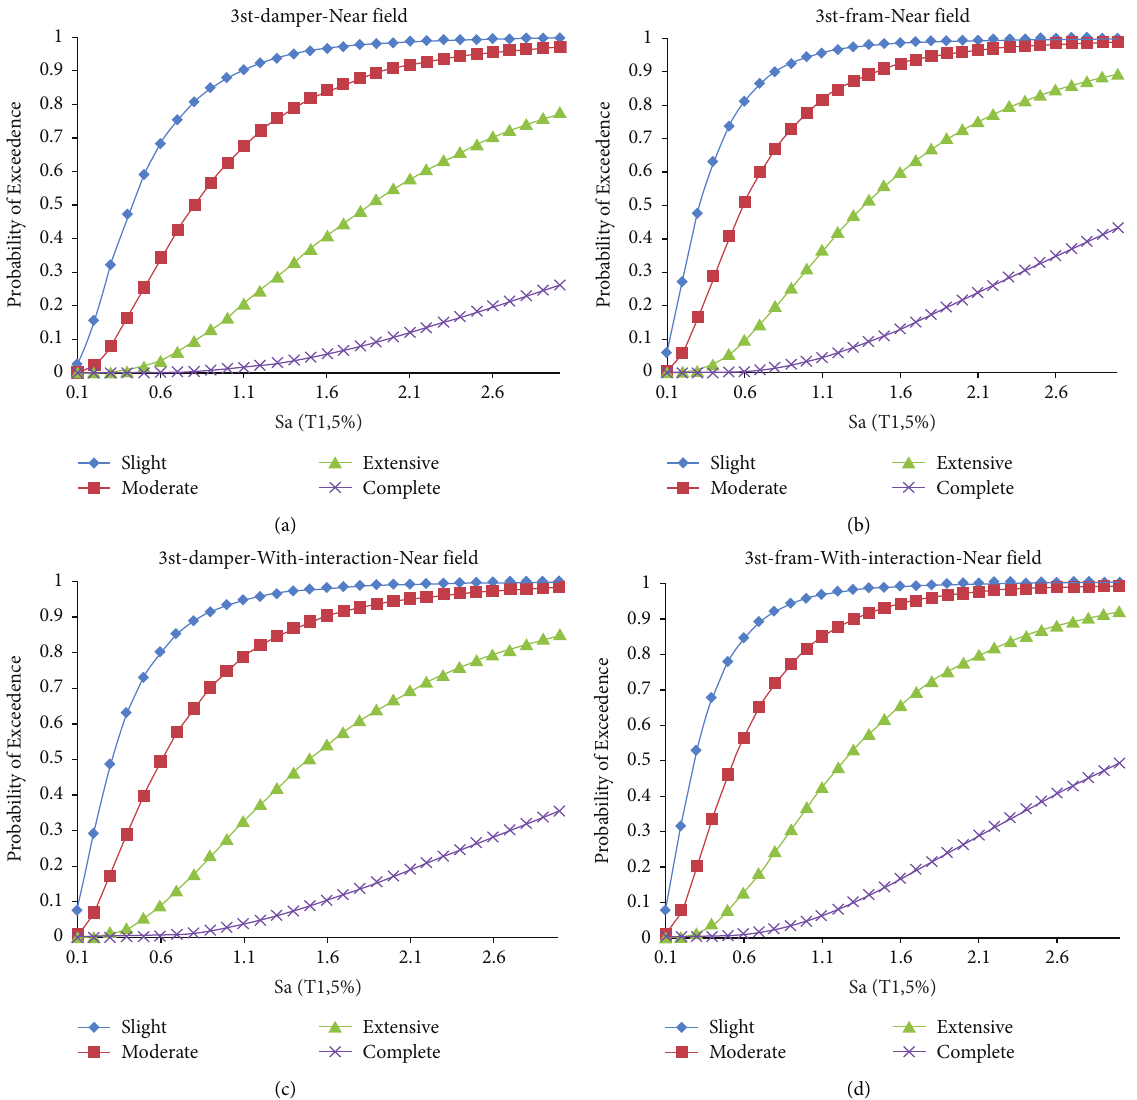
Figure 6: Fragility curves in 3-story ordinary moment resisting frame affected by near-field earthquakes. Examined cases: (a) with damper without considering SSI; (b) without Damper and SSI effect; (c) with damper and considering SSI; (d) without damper but considering SSI